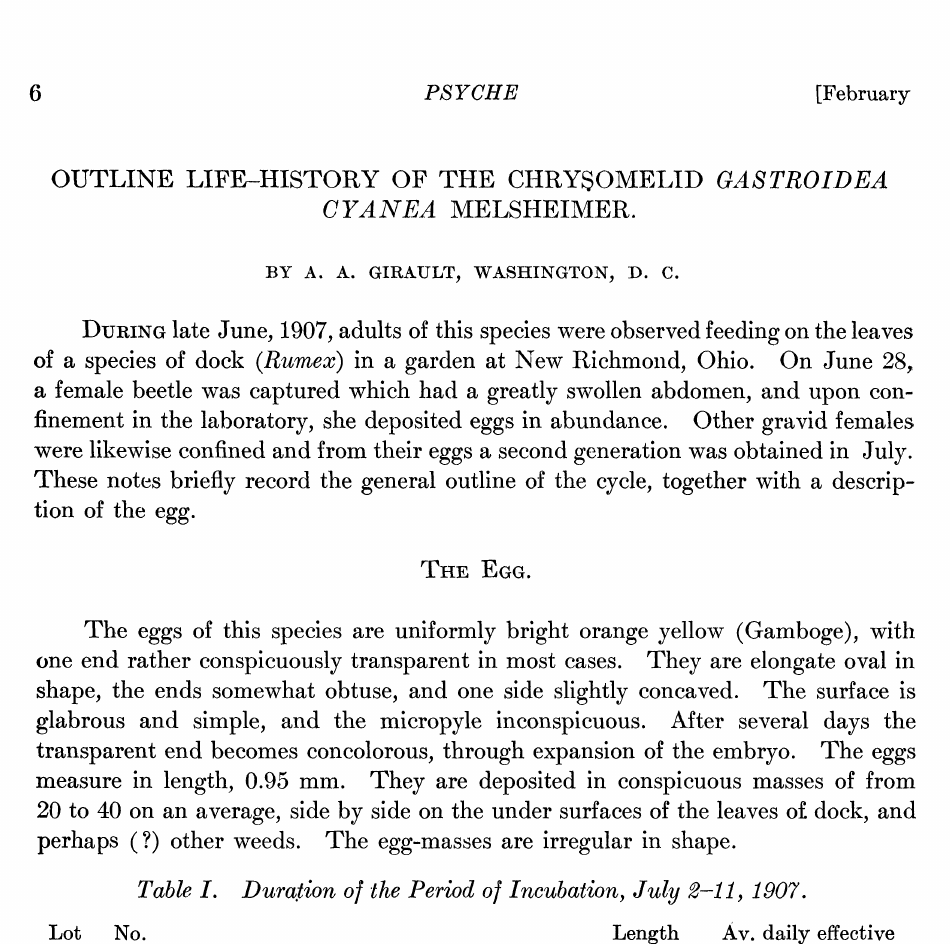
Table I. Duration of the Period of Incubation, July 2-11, 1907. Lot